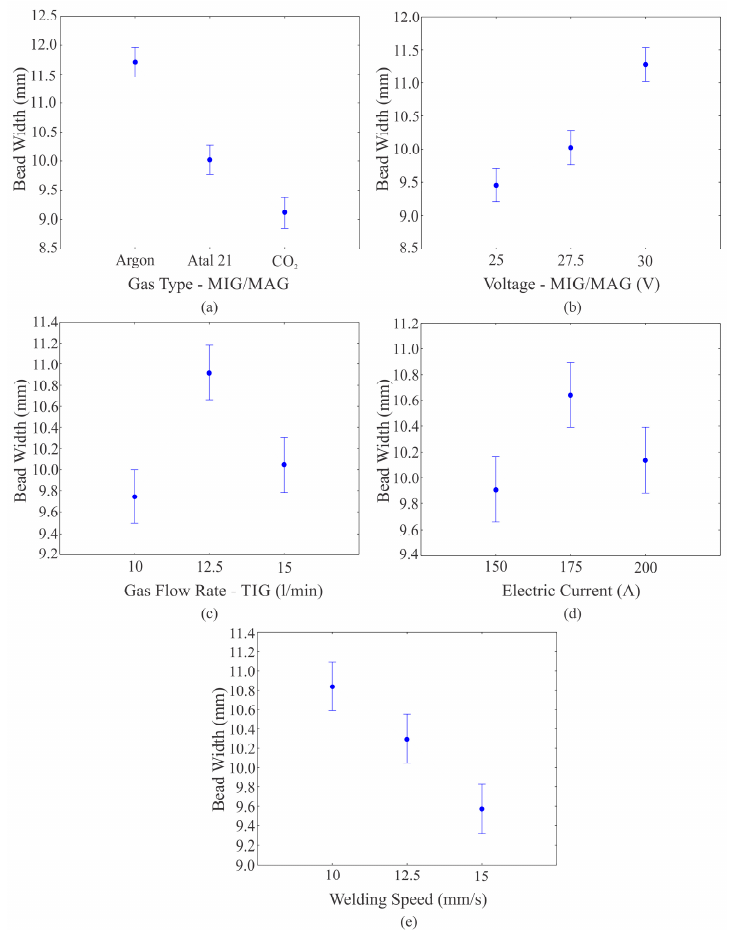
Figure 9. Effect of the solder factors on the width of the weld bead.